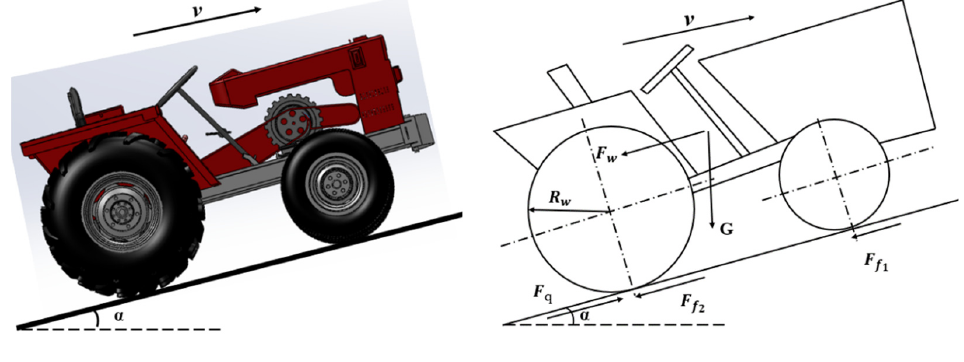
Figure 4. Tractor driving force analysis.